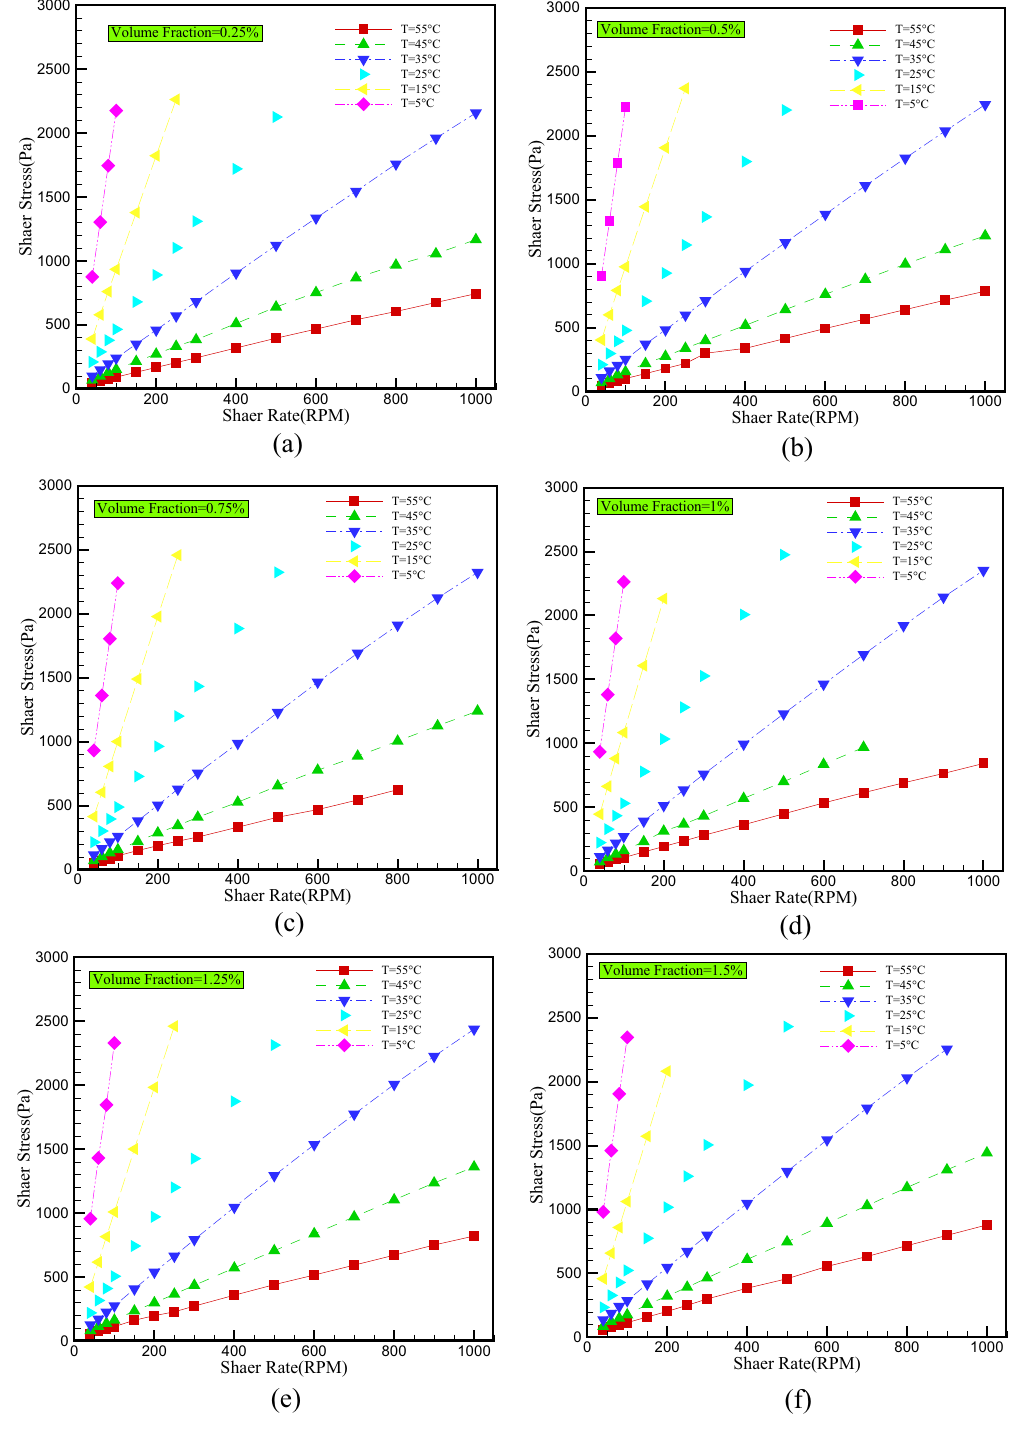
Figure 6. Shear stress versus shear rate for different temperature and VFs of ( a ) 0.25%, ( b ) 0.5%, ( c ) 0.75%, ( d ) 1%, ( e ) 1.25%, ( f )